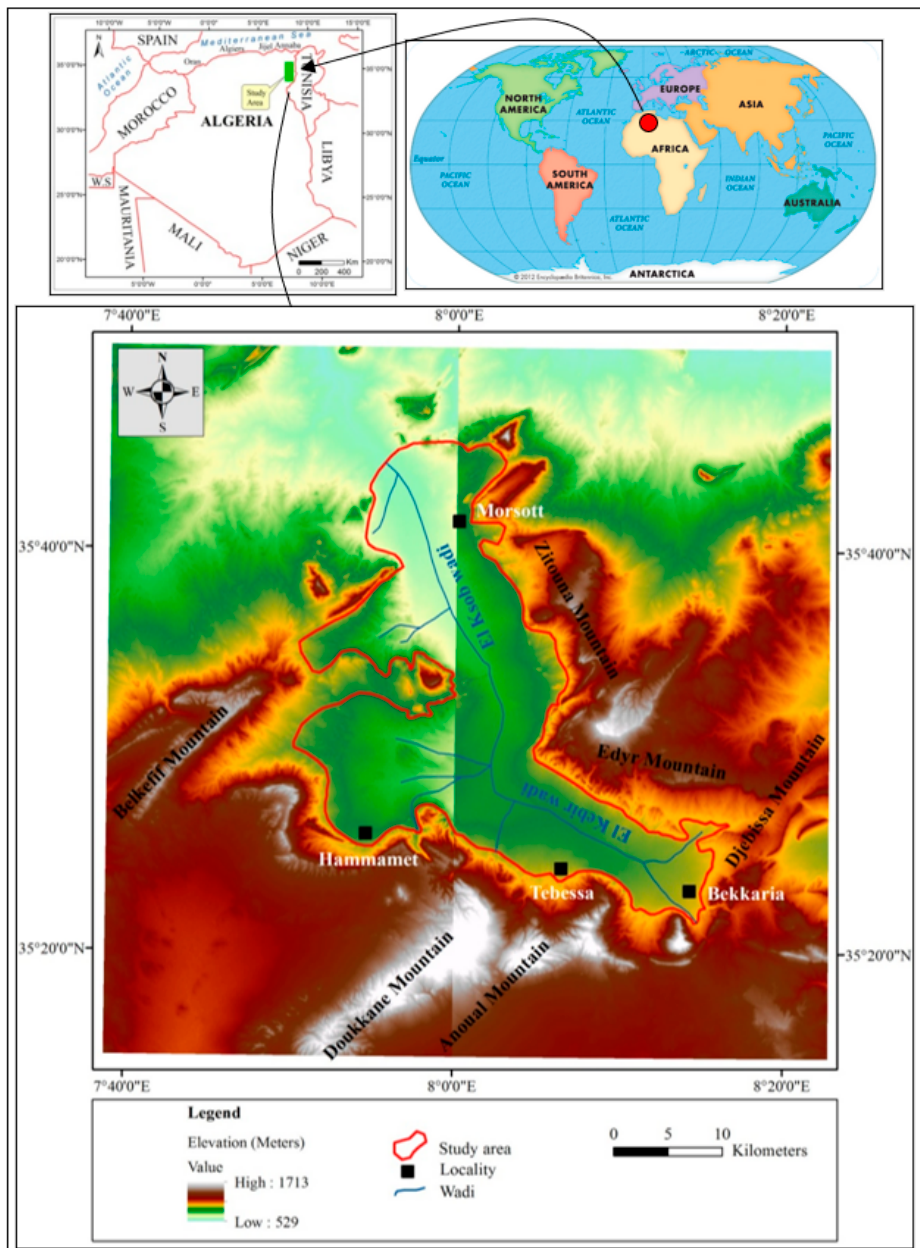
Figure 1. Geographic location and topography of the study area in northeastern Algeria.